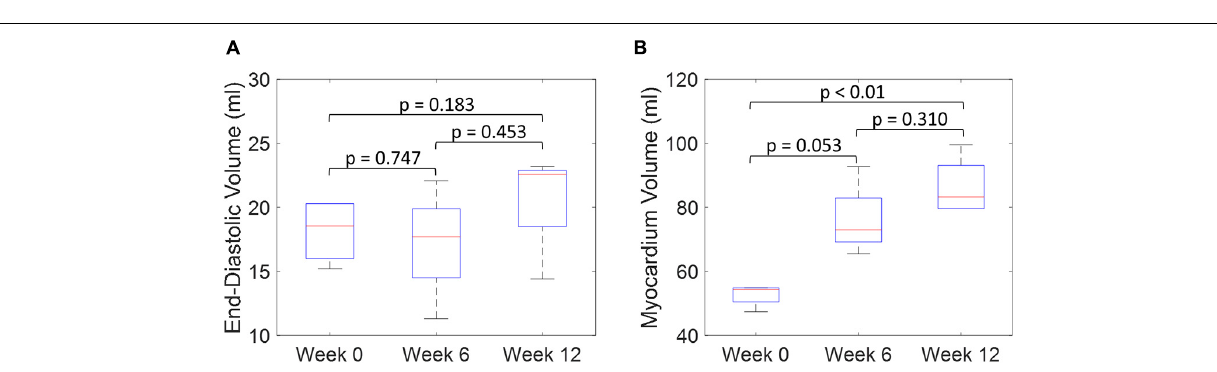
FIGURE 11 | Quantitative comparison of end-diastolic volume (A) and myocardium volume (B) between the preloaded LVs at week 0 and the predicted growth LVs at weeks 6 and 12. (Boxplots show median, interquartile ranges, and whiskers show range. P -values were calculated using standard t